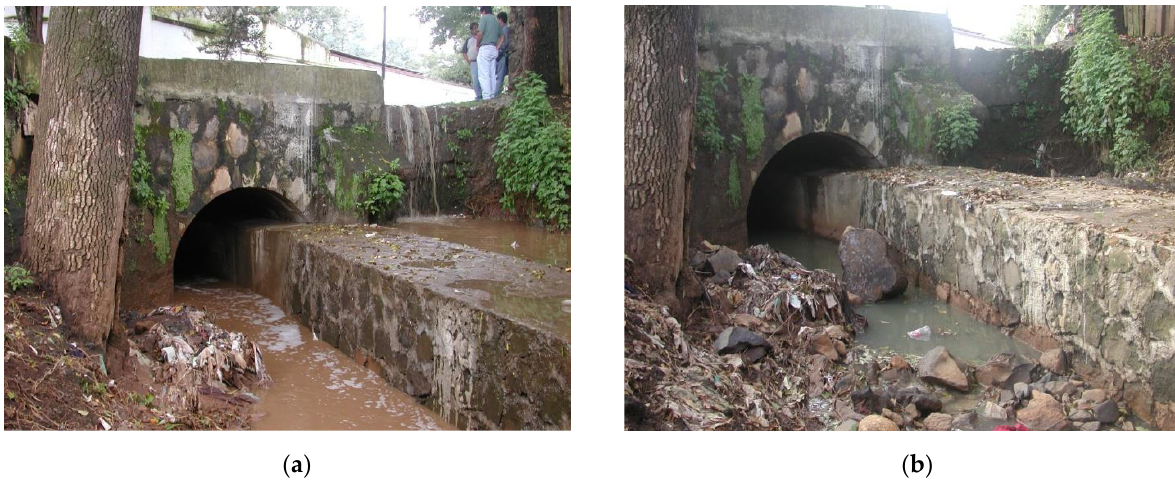
Figure 7. Sewer obstructed by the inside wall construction. ( a ) Before the flood; ( b ) after the flood.